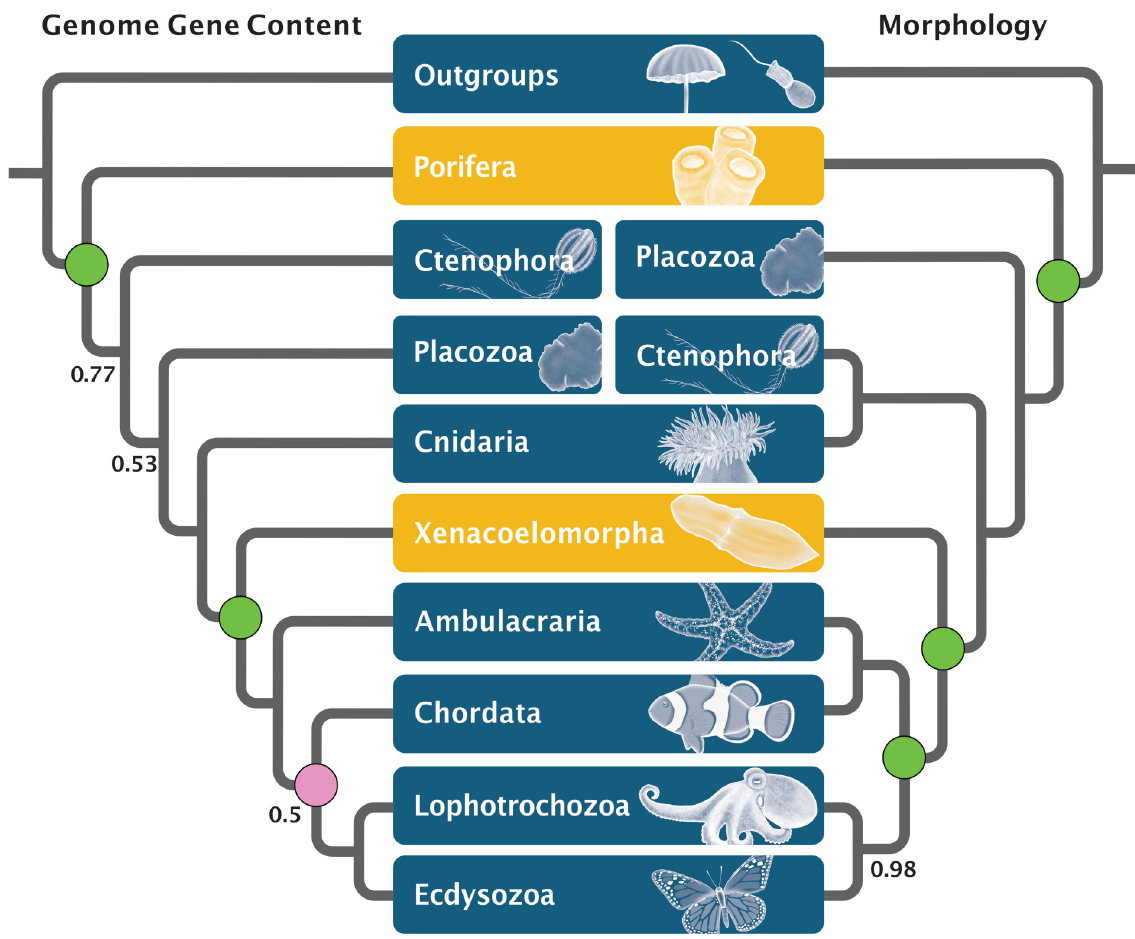
Fig 2. Reconstruction of animal phylogeny with 47 species (Opi taxon sampling) based on gene content datasets (TPCT) and morphological data. Left : Total consensus tree of > 10.5 million individual tree samples from analyses using datasets of homogroups and orthogroups of all the different E- and I-values for genome gene content (for details see Materials and Methods, see S1 File for details of analytical settings). Right : morphology-based phylogeny based on the non-additive coding scheme.Note the different positions of Ctenophora. Second to branch off in gene content and sister group to Cnidaria in morphology (i.e., Coelenterata) analyses. The monophyly of Deuterostomia is strongly supported by morphology but around 50% by gene content datasets. Posterior probabilities lower than 0.99 are indicated on both phylogenies. Statistical hypothesis tests of focal nodes: Green circle = node is strongly supported in the majority of tests conducted; Purple circle = node is not strongly supported in the majority of tests conducted (see S9, S12, and S13 Figs for details). (S1C, S2–S5 Figs): Placozoa branched off before Ctenophora (e.g., Fig 3B), the relationship